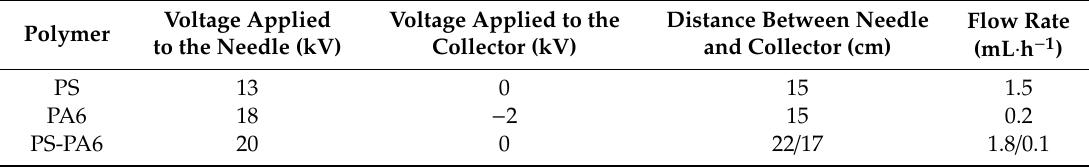
Figure 1. The electrospinning set-up consisting of two nozzles to produce polystyrene (PS) and PS with nylon 6 (PA6) fibers at the same time to obtain the composite meshes. Table 1. Electrospinning parameters of PS, PA6, and with two nozzles spinning at the same time to produce PS-PA6 composite meshes.